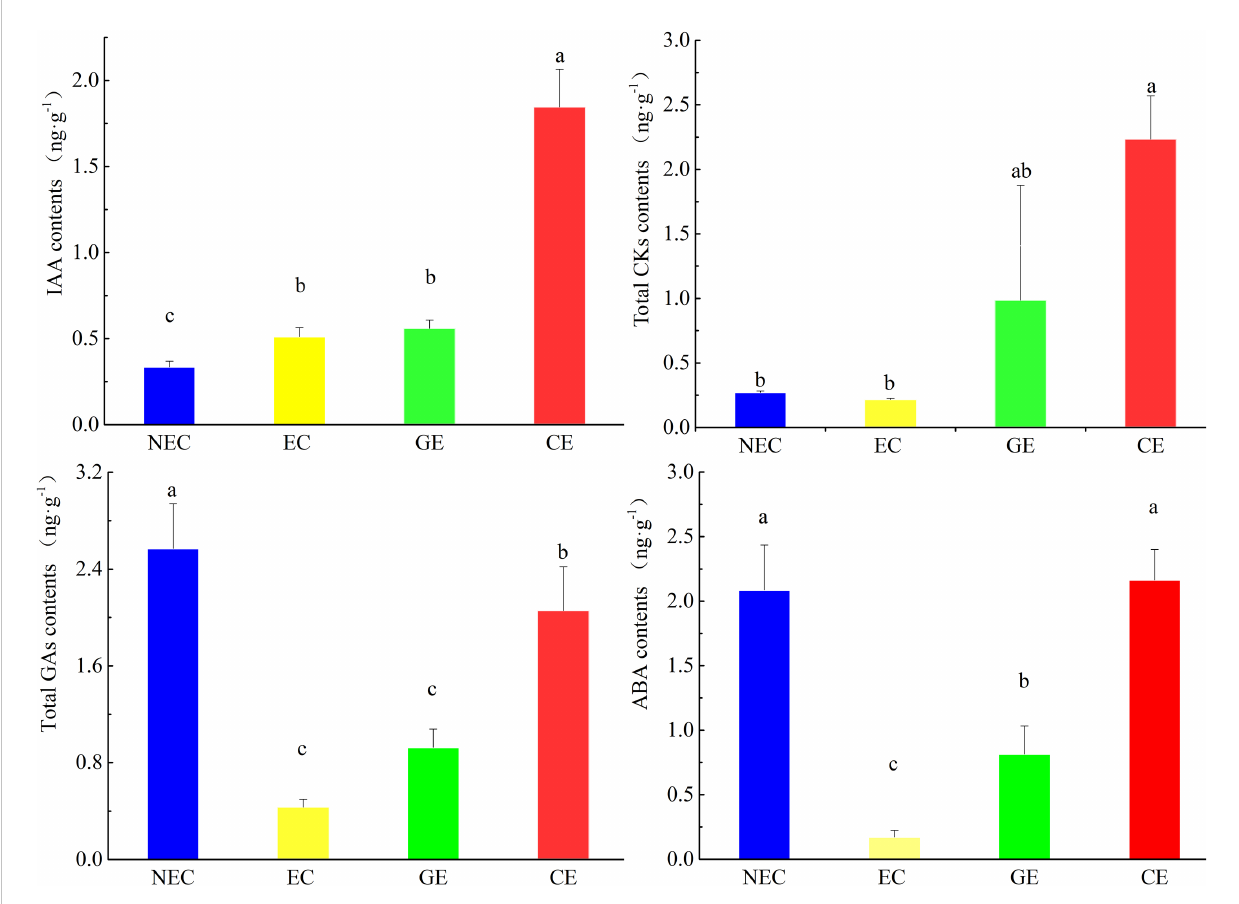
FIGURE 2 Contents of phytohormones at various phases of SE in O. henryi . Auxin is IAA, cytokinin content is the sum of IP, tZ, cZ and DZ, gibberellin content is the sum of GA1, GA3, GA4, GA7, GA9, GA15, GA19, GA20, GA24 and GA53, and abscisic acid is ABA. The different lowercase letters are signi fi cantly different using the Tukey ’ s test (P<